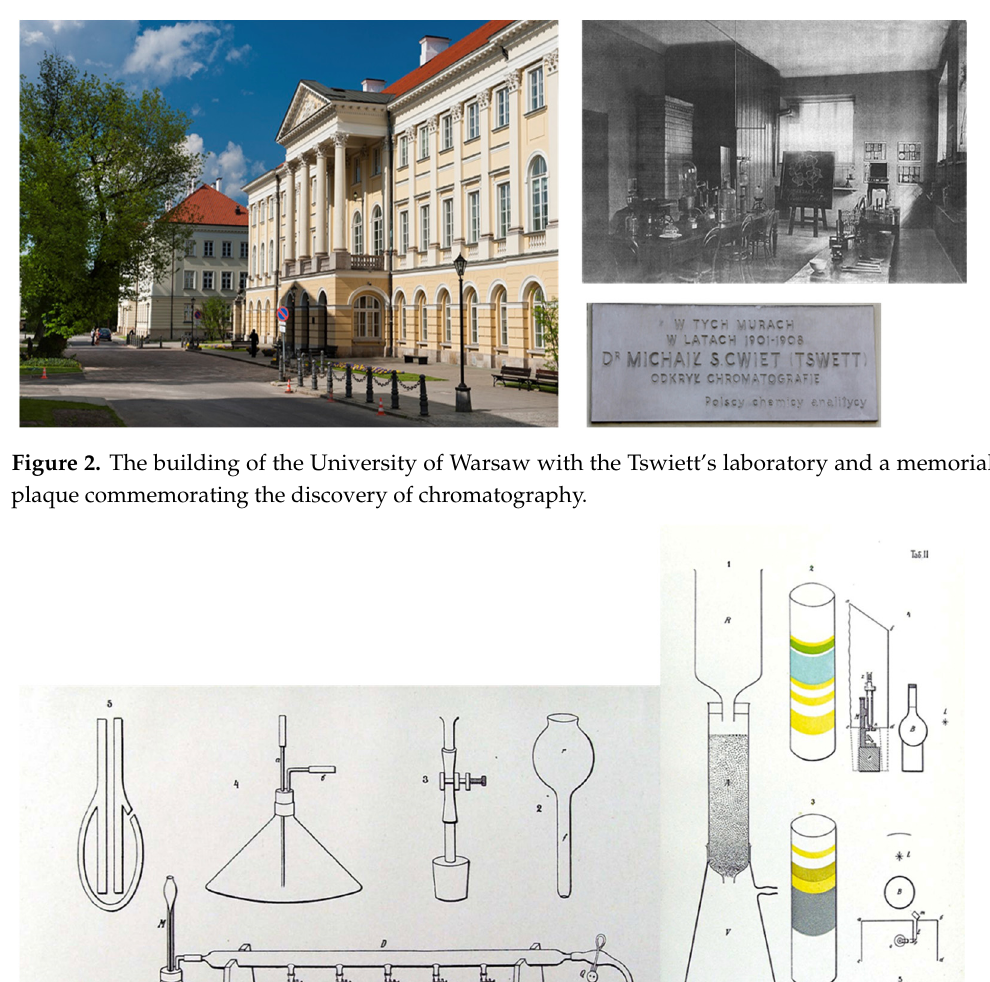
Figure 2. The building of the University of Warsaw with the Tswiett’s laboratory and a memorial plaque commemorating the discovery of chromatography.